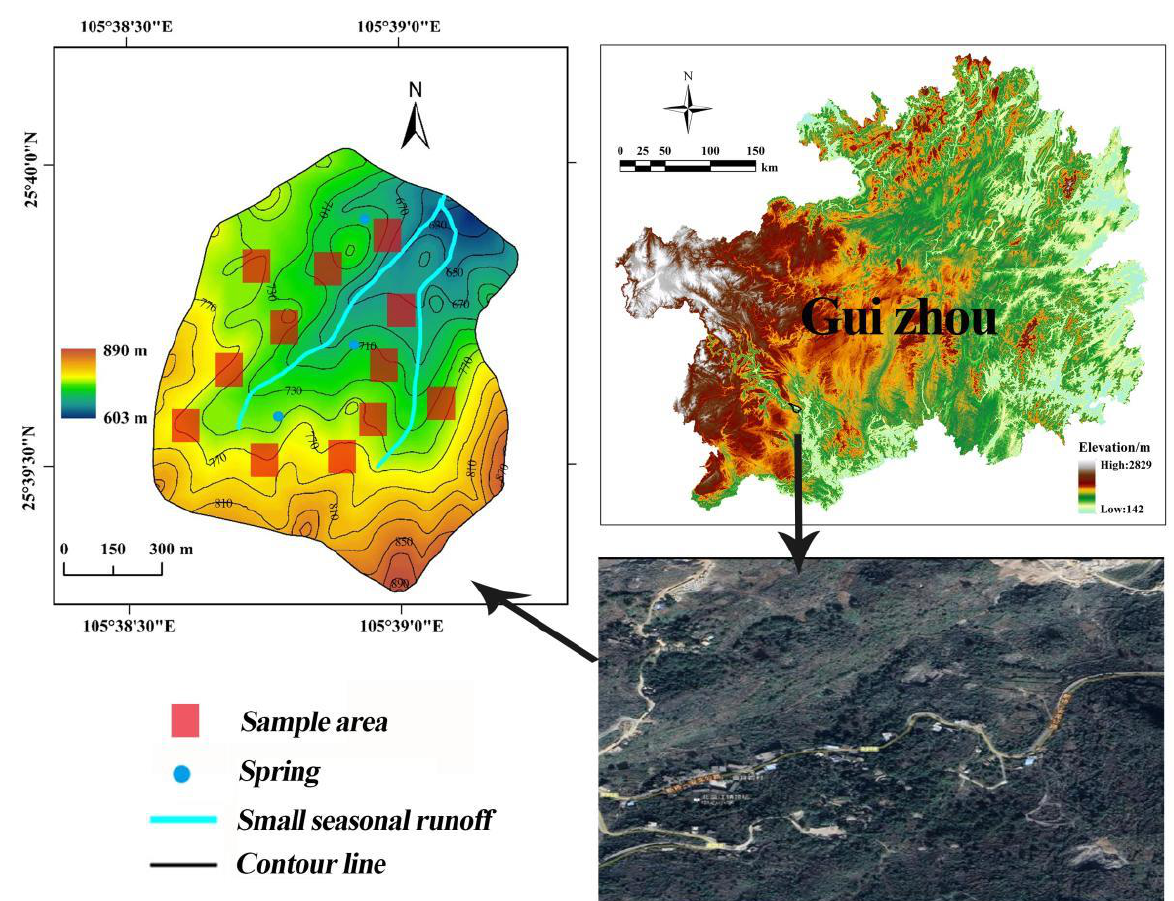
Figure 1. Geographical location of the study area. The left is a sampling point map, and the right is a regional satellite map. Juglans regia , Zanthoxylum bungeanum Maxim , Eriobotrya japonica , and Lonicera japonica these four plants are represented by their Chinese abbreviations in the following articles and charts, which are HT, HJ, PP, and JYH in the above order.